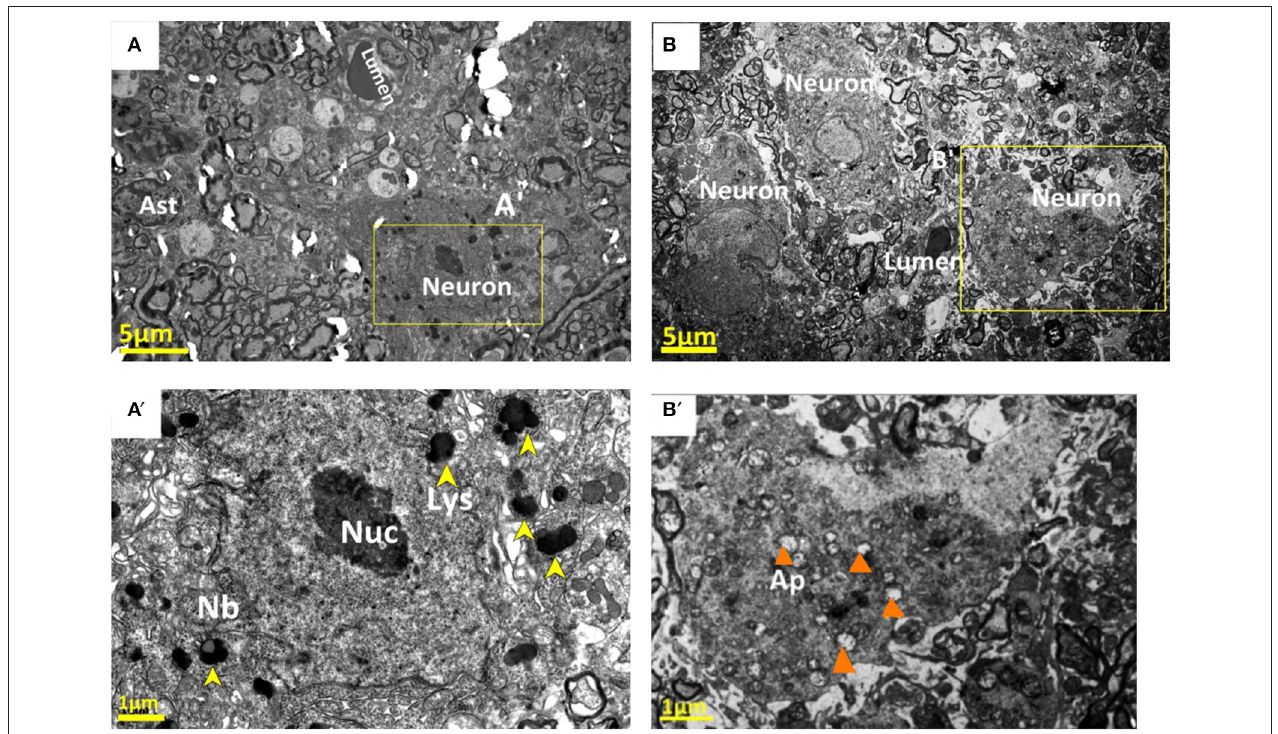
FIGURE 9 | Normal nucleolus (Nuc), Nissl bodies (Nb), and lysosomes (Lys) were shown in the neuronal cytoplasm in the control group (A,A ′ ) . Corresponding neurons in the compression group showed morphological signs of neurodegeneration, numerous phagolysosomes and autophagic vacuoles (Ap) were seen in the cytoplasm of neurons (B,B ′ ) . The yellow arrowheads stand for “lysosomes (Lys)”; and the orange arrowheads for “autophagic